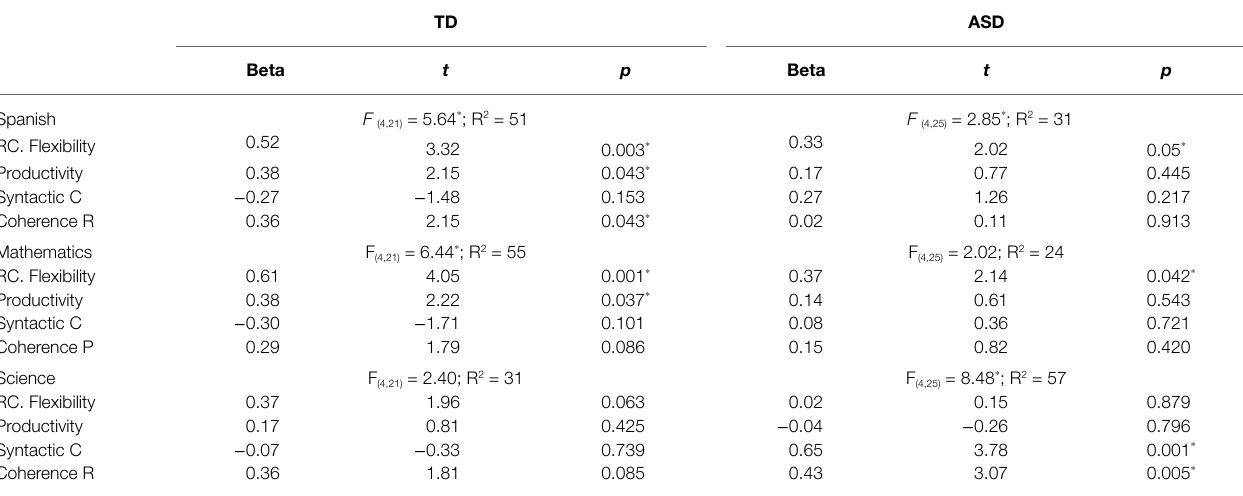
TABLE 5 | Multiple regression analysis of reading and writing skills that predict academic outcomes in TD and ASD groups. TD ASD Beta t p Beta t p